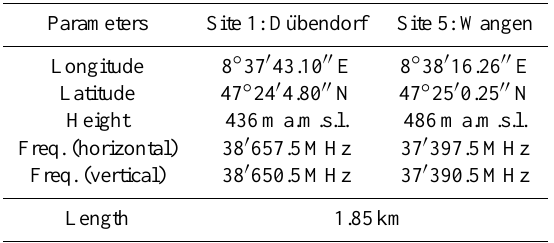
Table 1. Longitude, latitude, height and frequencies of the installed microwave